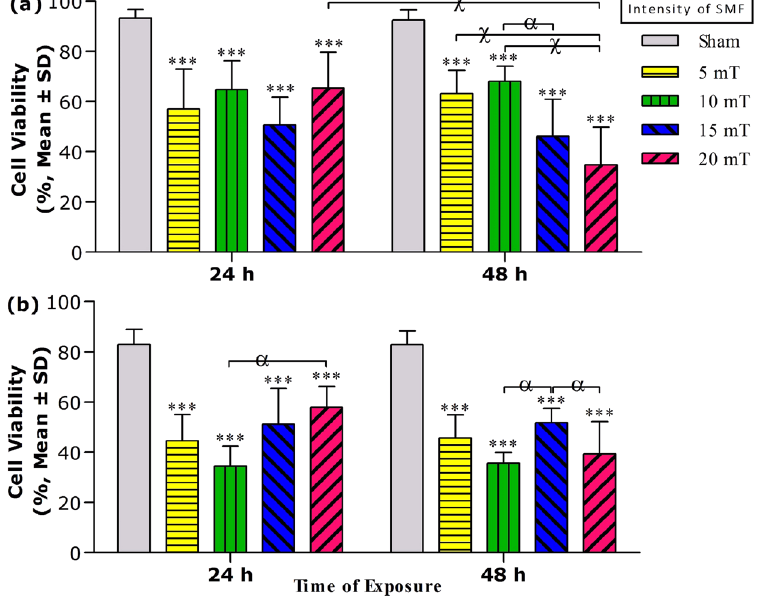
Figure 1. The cell viability results of ( a ) MCF-7 and ( b ) HFF cells exposed with SMF at different intensities (5, 10, 15 and 20 mT) for two exposure times (24 and 48 h). The cell viability value was determined by Trypan blue assay, and results are expressed as the percentage of viable cells. Data are shown as mean ± SD (n = 3). *** P < 0.001 . Significant difference relative to unexposed cells (sham), and letters ( α , P < 0.05 ; χ , P < 0.001 ). Significant differences between treated cells (5 × 2 factorial ANOVA flowed by post-hoc Newman–Keuls multiple comparison